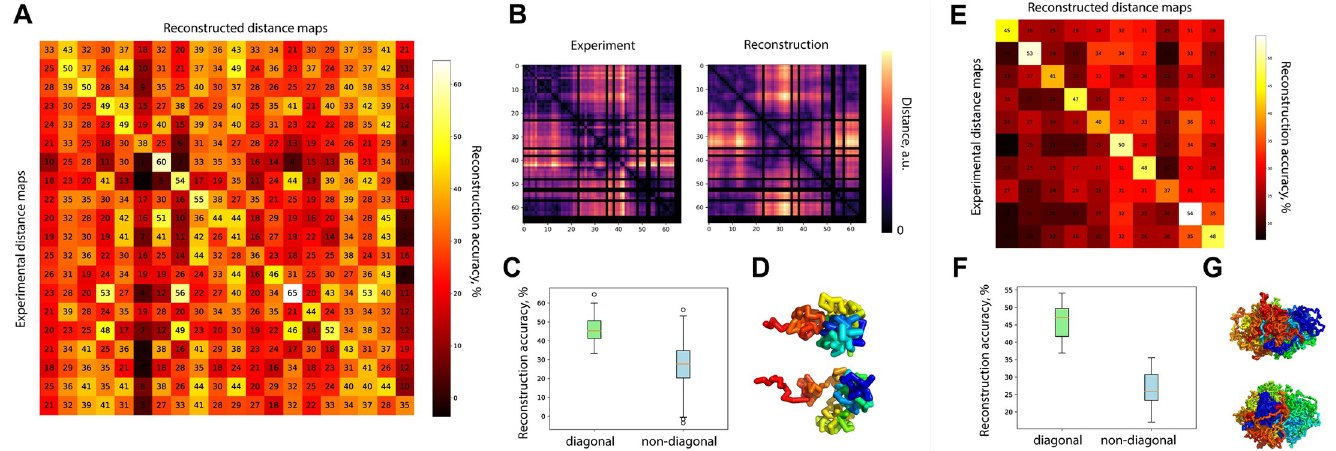
Fig 6. A . Pairwise comparison of distance maps corresponding to experimental data [32] and reconstructed 3D model. In a cell unit, a number indicates reconstruction accuracy, %. B . Example of experimental and reconstructed distance maps corresponding to 28 − 30Mb of chromosome 21. Distance map of the reconstructed structure masked with the same pattern as the experimental one has. C . Boxplots of reconstruction accuracies, diagonal elements correspond to matching structure and map, such as i-th experimental dataset and i-th reconstructed structure. Non-diagonal elements correspond to i-th experimental dataset, j-th reconstructed structure. D . Examples of two reconstructed 3D structures from (A). E . Pairwise comparison similar to (A) but for another experimental data [33]. F . Boxplots of reconstruction accuracies, similar to (C). G . Examples of two reconstructed 3D structures from (E).